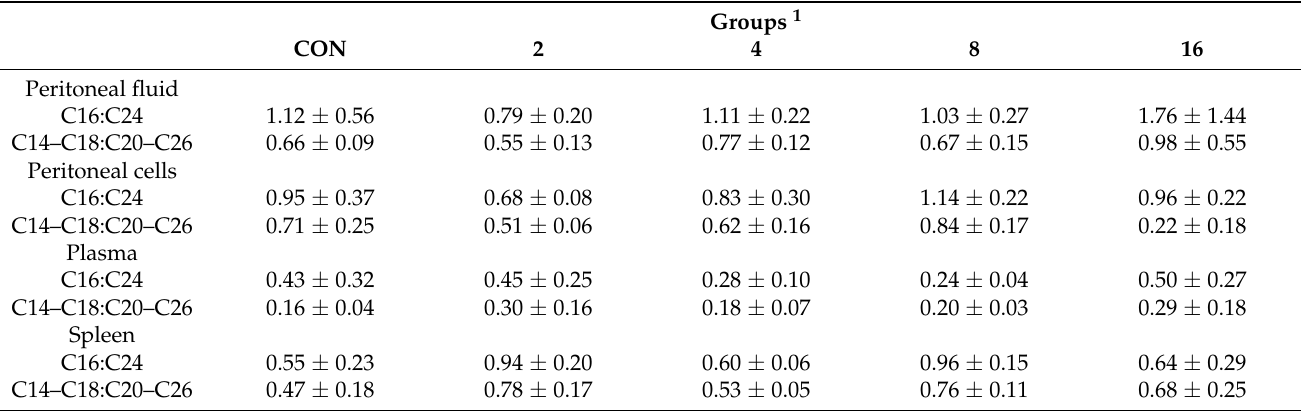
Table 3. Ceramides ratios measured in the peritoneal fluid, peritoneal cells, plasma, and the spleens of mice injected with zymosan or